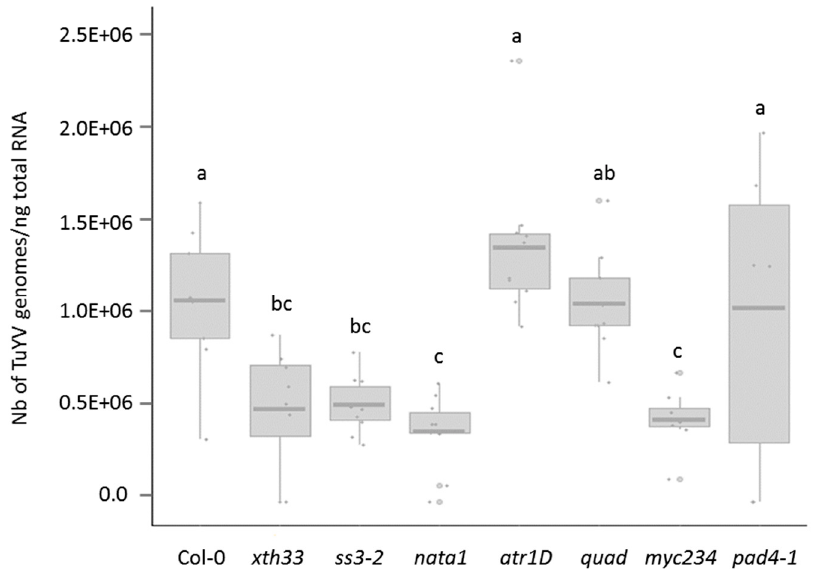
Figure 1. TuYV accumulation in A. thaliana mutant lines is assessed by qRT-PCR. The number of TuYV genome copies are normalized to ng of total plant RNA. This graph represents one experiment in which all plants are grown simultaneously and inoculated with viruliferous aphids from the same batch. Each dot corresponds to a plant sample. Box plots show median (line), 25%–75% percentiles (box) and 10%–90% percentiles (whiskers). TuYV accumulation varies with A. thaliana mutant lines (generalized linear model (GLM), df = 64, F = − 10.38, p < 0.001). Letters show significant differences between plants as tested with a GLM followed by pairwise comparisons using estimated marginal means (Tukey’s method). Eight to ten plants per accession are tested in technical triplicates. Each point corresponds to the mean of the triplicates.